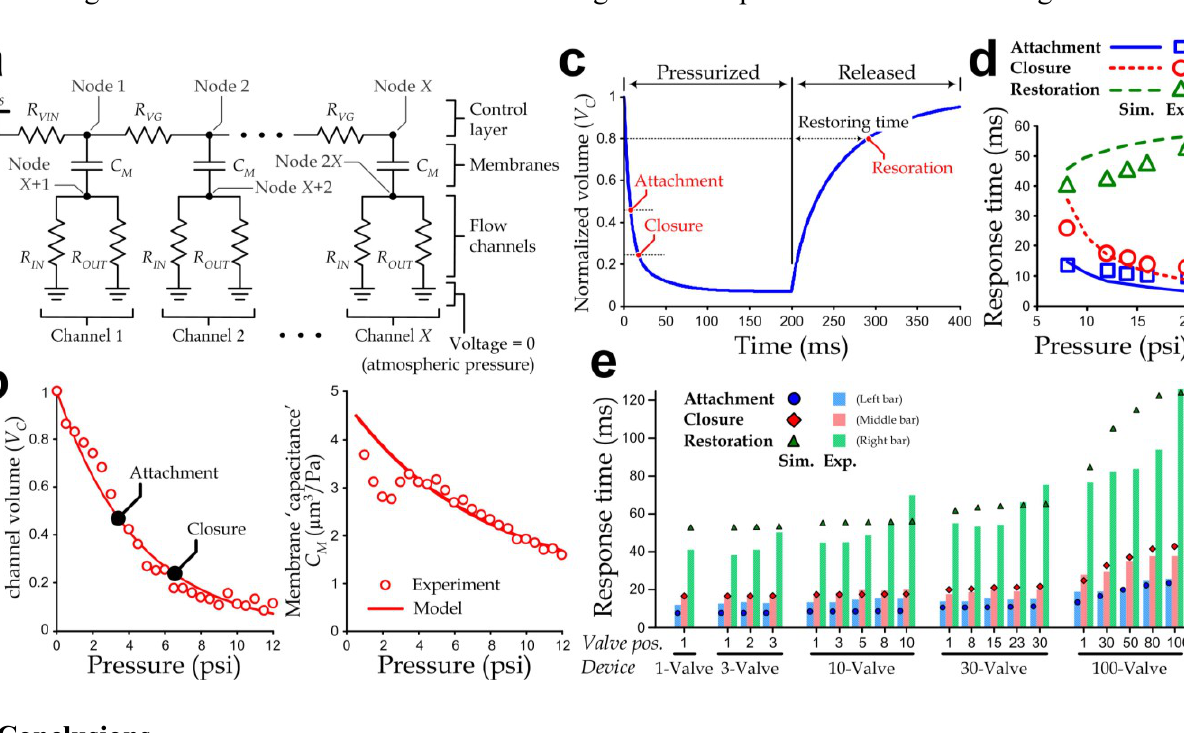
Figure 5. ( a ) Lumped circuit model of a multiple-valve device. The driving pressure V S was set as square-wave inputs according to the operation. C is equivalent capacitance for M the PDMS membrane. R , R , R and R are fluidic resistances of different channels VIN VG IN OUT in the device; ( b ) Plots of channel volume in the valve region ( left ) and membrane stiffness ( right ) as functions of the net downward pressure acting on the membrane; ( c ) Transient V C of a microvalve (valve position “1” in a 100-valve device) under the actuation and deactuation of V ; ( d ) Attachment, closure and restoring times of the single-valve devices. S Only average values of the experimental results from Figure 3 are shown here; ( e ) Comparison of the responses times between the experimental values and the predictions using the circuit models. The bars indicate averages of the experimental values from Figure